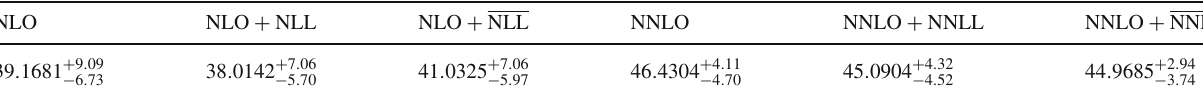
Fig. 4 μ F scale dependence of SV + NSV part of the fixed order result till NNLO accuracy for Higgs boson production via gluon fusion at μ R = m H / 2 and 13 TeV